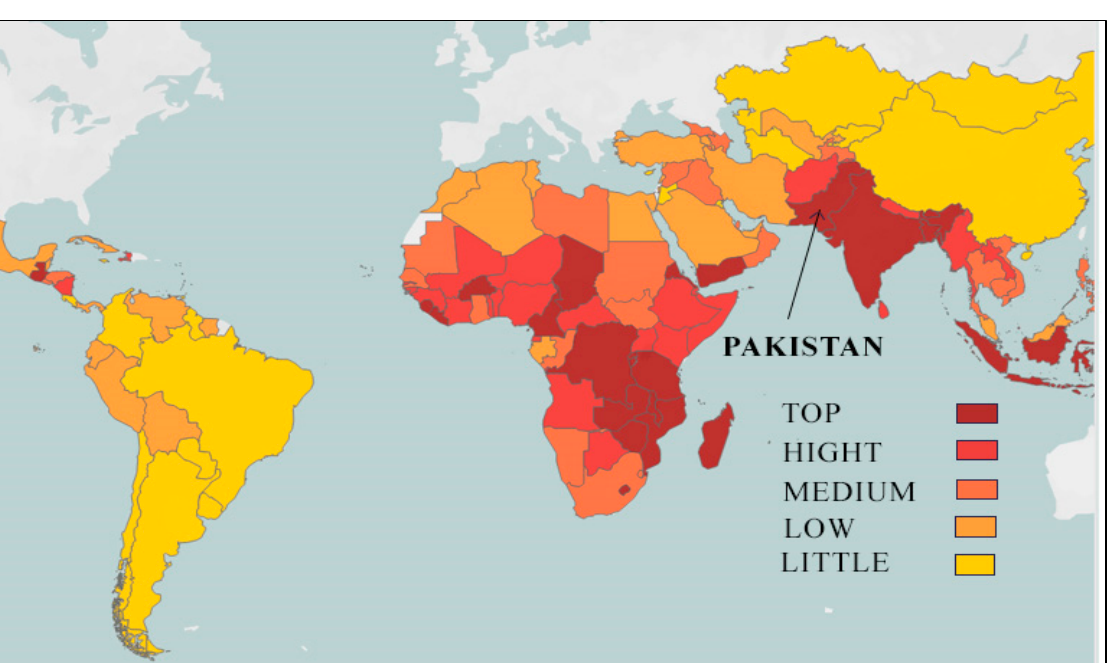
Figure 1. Countries with zinc deficiency (source harvest plus): available at https://bpi.harvestplus.org/subindex_micronutrients.html?id=c2 (accessed on 5 April 2022).